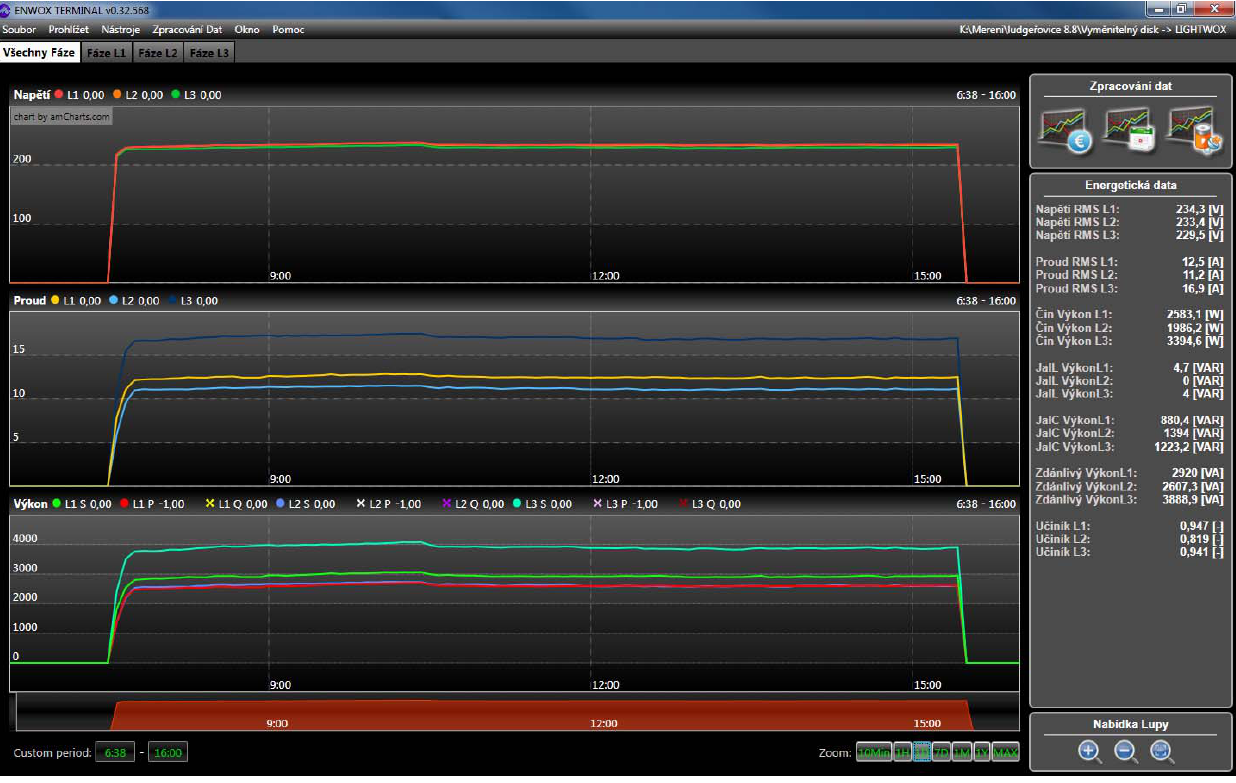
Figure 8. Main screen of the analyzing software. All necessary information is